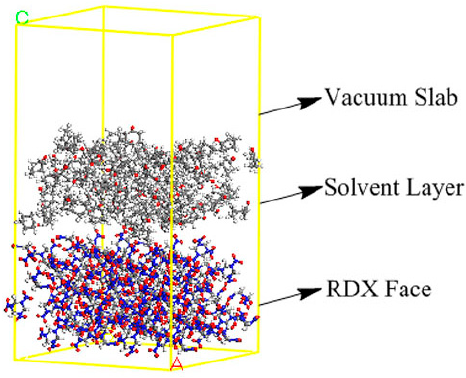
Figure 2. The typical interfacial model between a RDX face and solvent molecules.